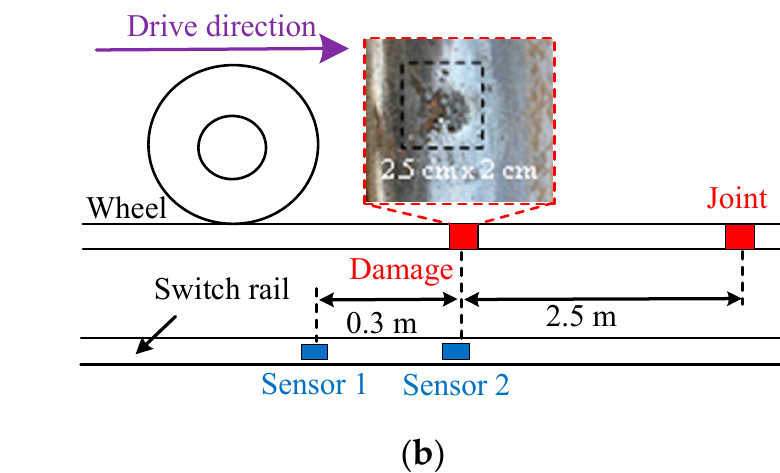
( b ) Figure 3. The track inspection car and wheelset distances: ( a ) track inspection car; ( b ) wheelset dis- tance parameters of track inspection.